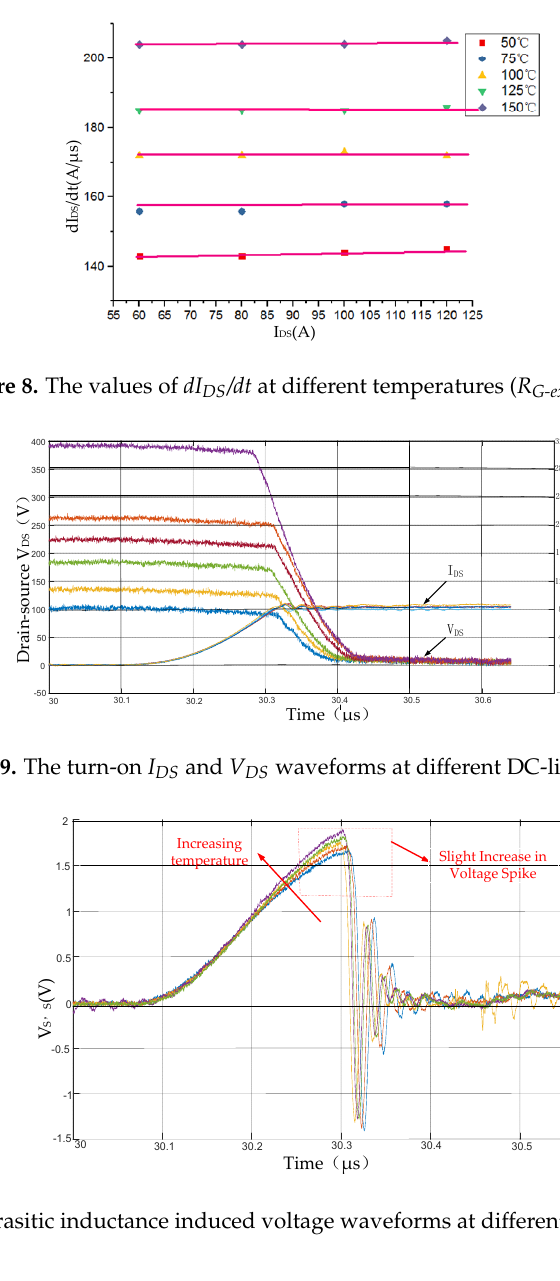
Figure 7. The measured I DS turn ‐ on current transients for different load currents ( R G ‐ ext = 60 Ω , T j = 150 °C).